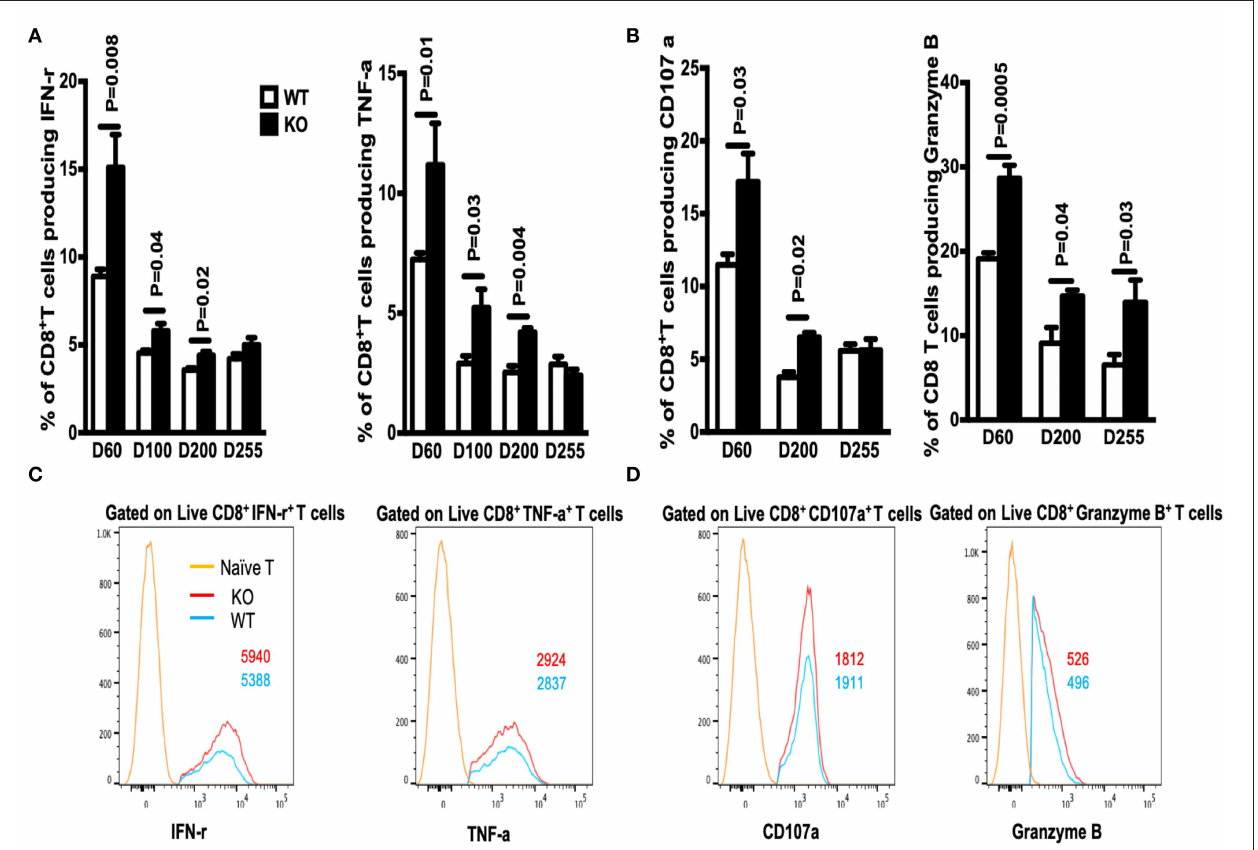
FIGURE 6 | The percentage of cytokine-producing CD8 + T cells in WASp − / − mice increases during the maintenance stage. On the indicated days after LCMV infection, spleenocytes were stimulated with GP33-41 peptide in vitro and Ag-induced cytokine production was measured by intracellular staining. (A) Percentages of IFN- γ + (left panel) or TNF- α + cells (right panel) within the CD8 + T cell population. (B) Percentages of CD107a + (left panel) or Granzyme B + cells (right panel) within the CD8 + T cell population. (C) Representative data showing expression of IFN- γ (left panel, gated on Live CD8 + CD44 + IFN- γ + cells), and expression of TNF- α (right panel, gated on Live CD8 + CD44 + TNF- α + cells). (D) Representative data showing CD107 α expression (left panel, gated on Live CD8 + CD44 + CD107 α + cells), and Granzyme B expression (right panel, gated on Live CD8 + CD44 + Granzyme B + cells). Representative data showing cytokine production on D60; naïve T cells were used as a negative control. The numbers in the histograms represent the MFI for the indicated protein. Data are expressed as the mean ± SEM ( n = 3–8 mice) (WT littermate mice: D30, n = 4; D60, n = 7; D100, n = 7; D200, n = 3; D255, n = 5; WASp − / − mice: D30, n = 4; D60, n = 8; D100, n = 7; D200, n = 3; D255, n = 5). Data were analyzed using an unpaired t